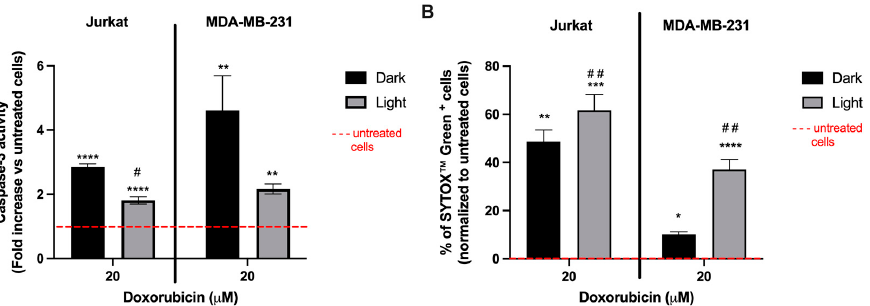
Figure 6. Caspase-3 activity ( A ) and percentage (%) of SYTOX™ Green-positive cells ( B ) in Jurkat and MDA-MB-231 cells after treatment with doxorubicin (20 µM) for 2.5 h followed or not by light irradiation for 30 min and 24 h recovery in drug-free complete medium. * p < 0.05; ** p < 0.01; *** p < 0.001; **** p < 0.0001 vs. untreated cells. # p < 0.05; ## p < 0.01 vs. nonirradiated cells.